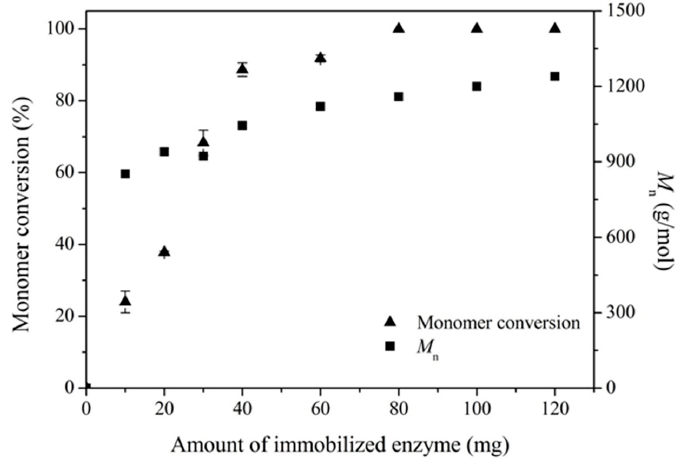
Figure 2. Monomer conversion ( ▲ ) and M n ( ■ ) as a function of the amount of immobilized enzyme EC-EP-AFEST in the ring-opening polymerization of ε -caprolactone. The reactions were carried out using 200 μ L ε -caprolactone and 600 μ L toluene at 80 °C for 72 h.